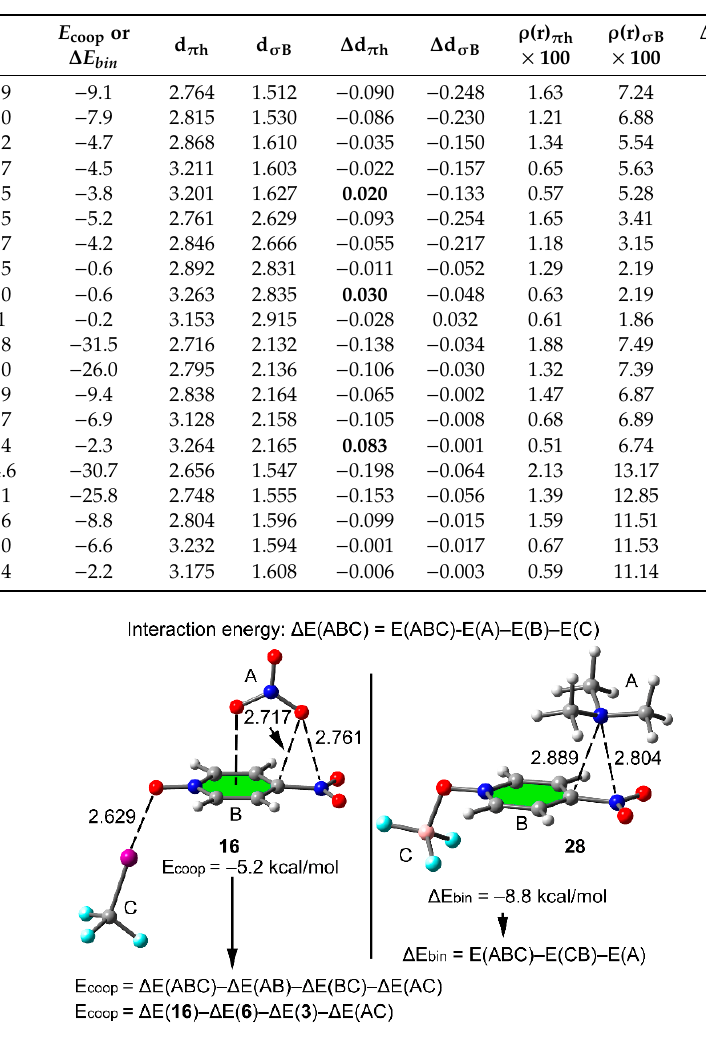
Table 3. Interaction, binary, and cooperativity energies ( Δ E , Δ E bin, and E coop , respectively, in kcal mol − 1 ) for complexes 11 – 30 at the PBE0-D3/def2-TZVP level of theory. Equilibrium distances in Å denoted as d π h for π –hole and d σ B for the HB/XB/CB/TrB interaction. The increment or decrement (in bold) of the equilibrium distances denoted as Δ d π h and Δ d σ are also included. The values of the charge density 100 × ρ (r) at the bond CP and its variation 100 × Δρ (r) for complexes 11 – 30 are given in a.u.